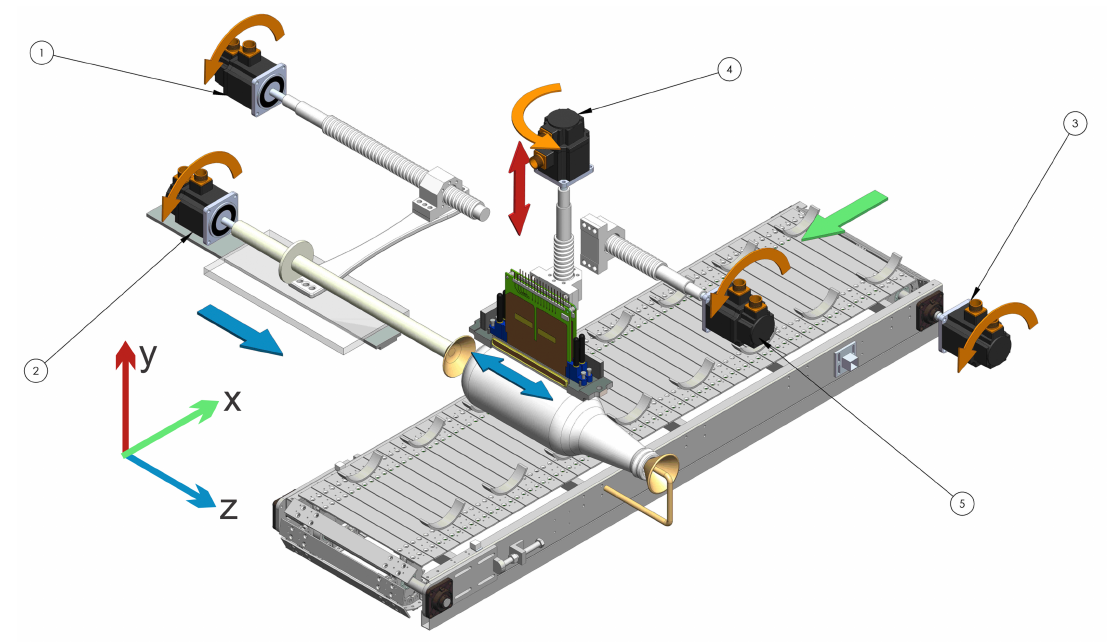
Figure 8. Scheme topology 1.